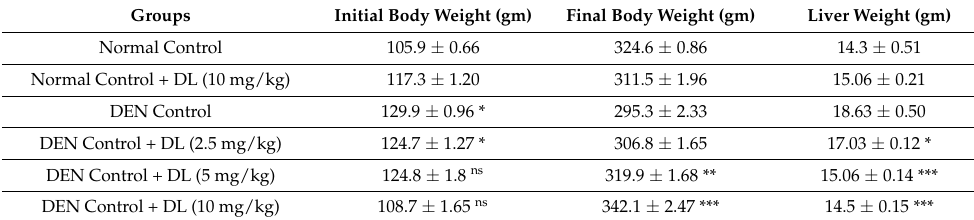
Table 1. Effect of DL on body and liver weight. This section may be divided by subheadings. It should provide a concise and precise description of the experimental results, their interpretation, as well as the experimental conclusions that can be drawn.